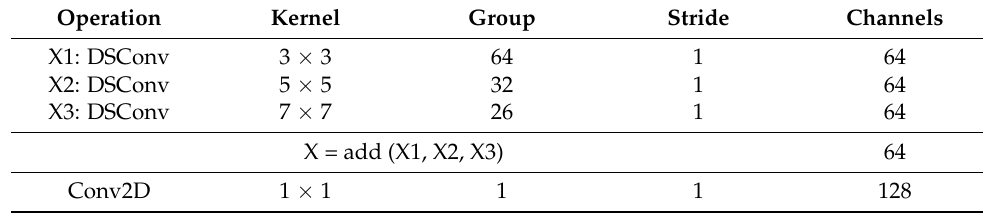
Table 4. Details Feature_s1 block.